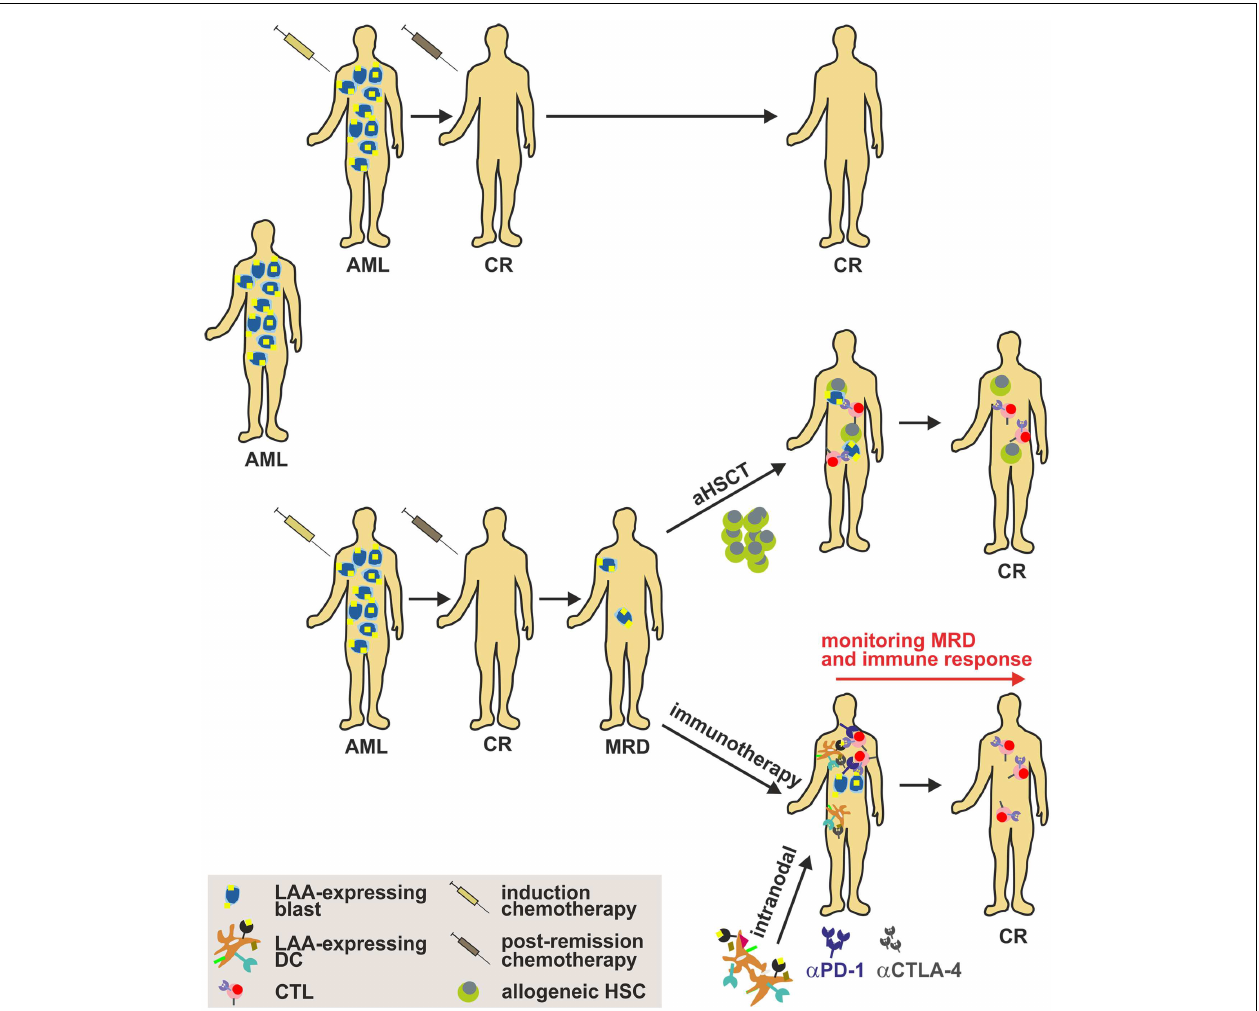
sustain CR. Importantly, DC-based immunotherapy targeting AML-specific LAAs alone or in combination with immune checkpoint inhibitors such as anti-CTLA-4 or anti-PD-1 mAbs might be a promising approach to treat patients and to target and eliminate LSCs. aHSCT, allogeneic hematopoietic stem cell transplantation; AML, acute myeloid leukemia; CTL, cytotoxic lymphocyte; CR, complete response; DC, dendritic cell; LAA, leukemia-associated antigen; MRD, minimal residual